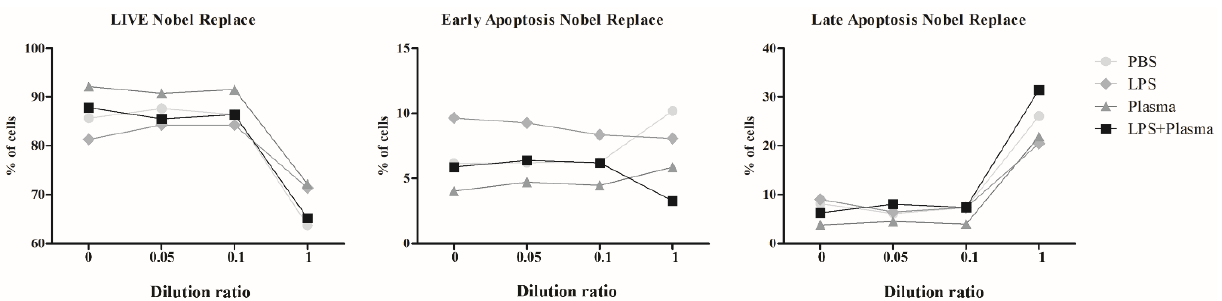
Figure 9. Viability of THP-1 cells after 24 h of incubation with NSMP from the Nobel Replace system. PBS, incubation with NSMP and PBS as a co-stimulator; LPS, incubation with NSMP and PBS as a co-stimulator; Plasma, incubation with NSMP and blood plasma from healthy donors as a co-stimulator; LPS + Plasma, incubation with NSMP and a combination of LPS and blood plasma from healthy donors as co-stimulators.